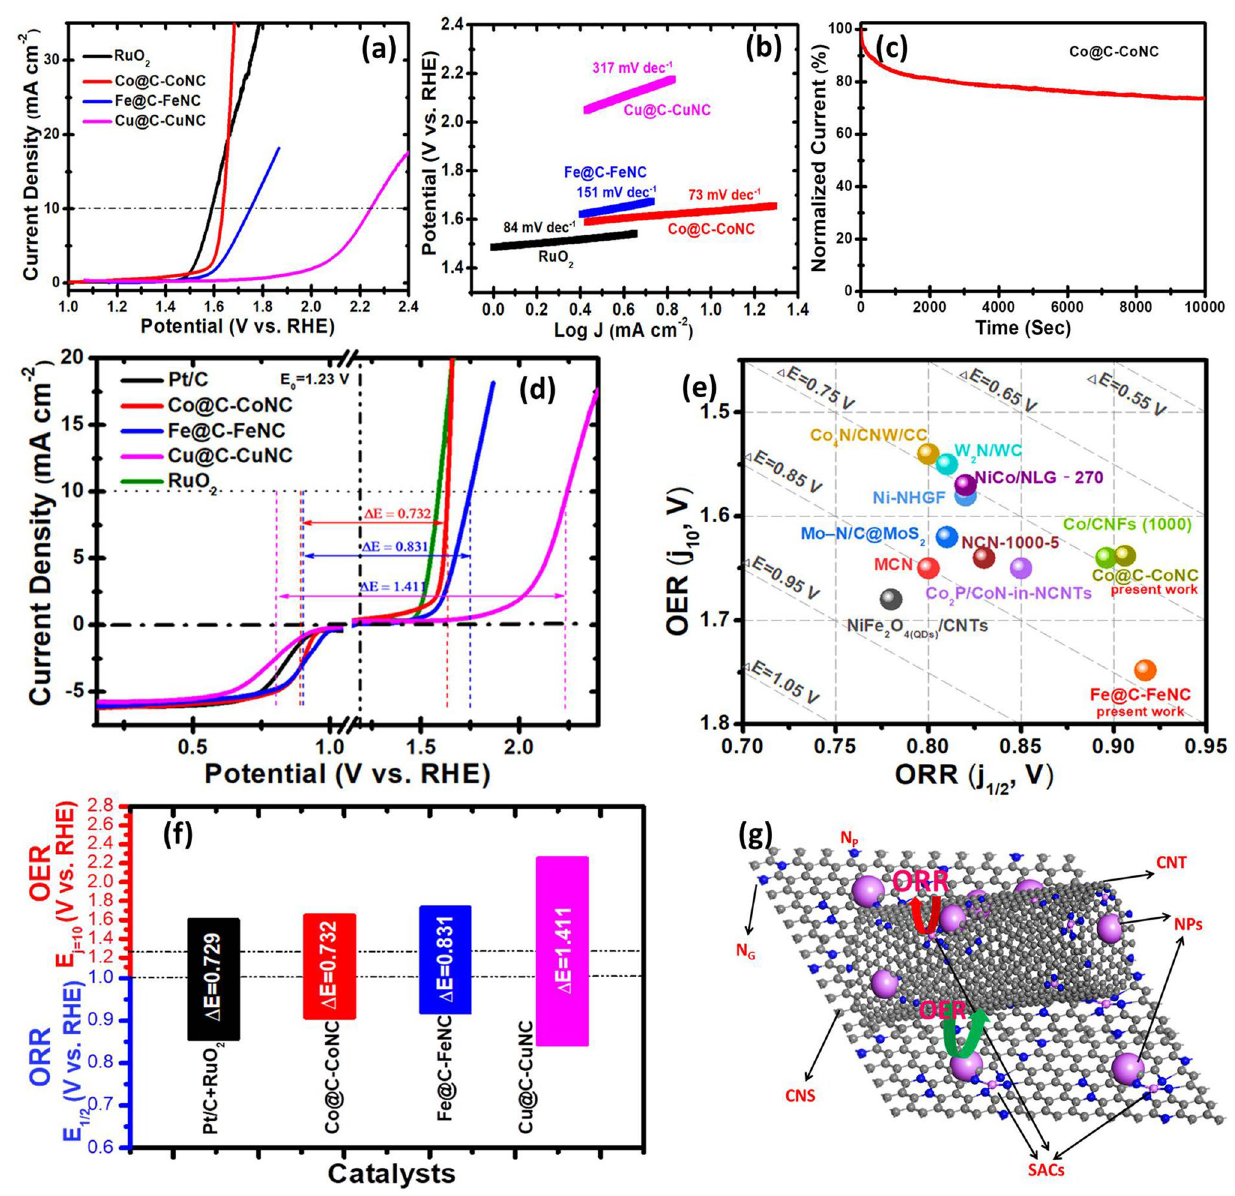
Fig. 5 a OER polarization curves and b their corresponding Tafel plots of Co@C-CoNC, Fe@C-FeNC, and Cu@C-CuNC, and RuO 2 catalysts in O 2 ‐ saturated 0.1 M KOH solution; c Durability tests of Co@C-CoNC catalyst in O 2 ‐ saturated 0.1 M KOH solution at a constant overpotential of 0.43 V (at 1600 rpm); d Electrocatalytic bifunctional LSV polarization curves of Co@C-CoNC, Fe@C-FeNC, and Cu@C-CuNC catalysts tested in O 2 ‐ saturated 0.1 M KOH electrolytes; e Comparison of the bifunctional activity with the literature data; f Summarized features and realizing the best robust alkaline OER, ORR, and bifunctional ORR/OER catalysts of the present study; g Proposed active sites for ORR and OER in the M–N–C